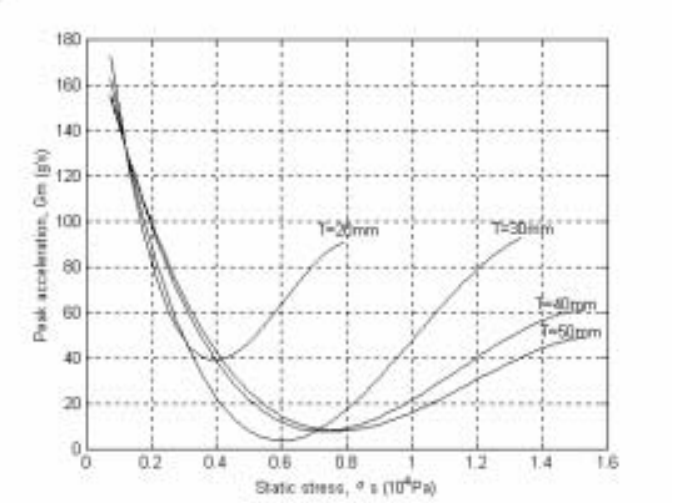
Fig. 9. Dynamic cushion curves of the honeycomb paperboards ( DH = 40